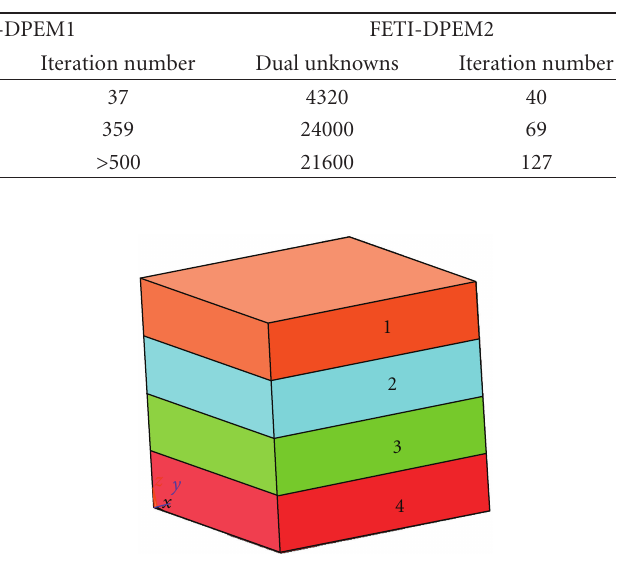
Figure 5: An inhomogeneous dielectric brick with four di ff erent